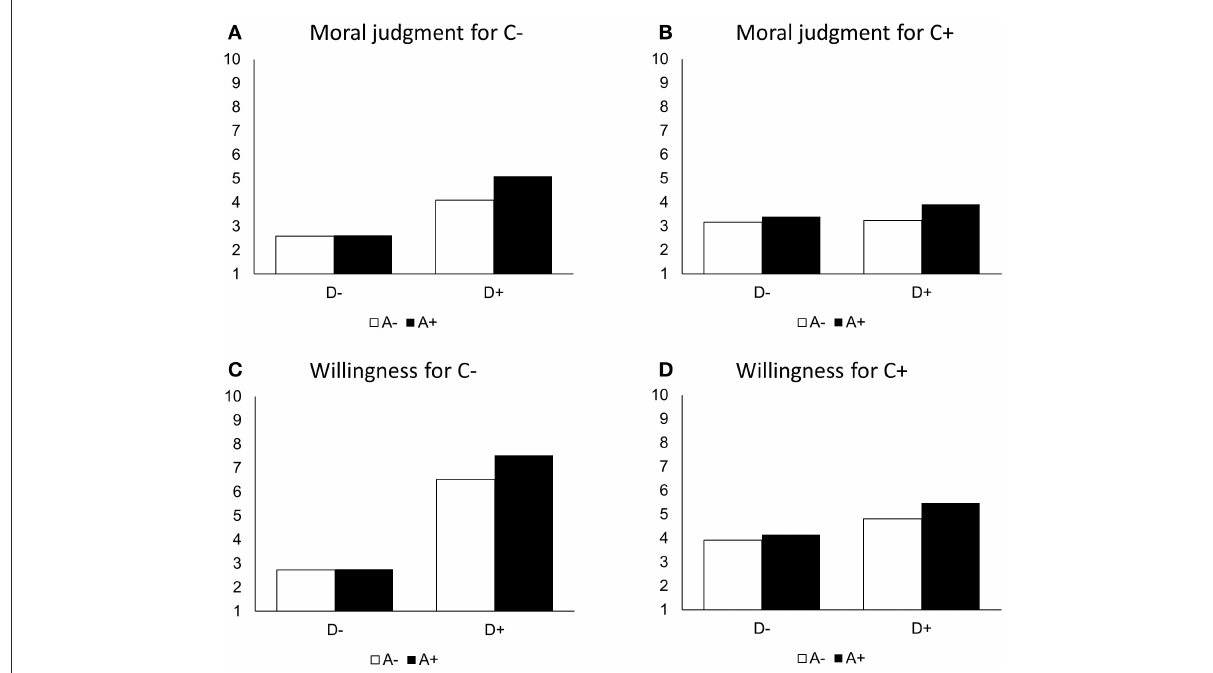
FIGURE3 Predicted values for moral judgment (A, B) and willingness (C, D) ( N =